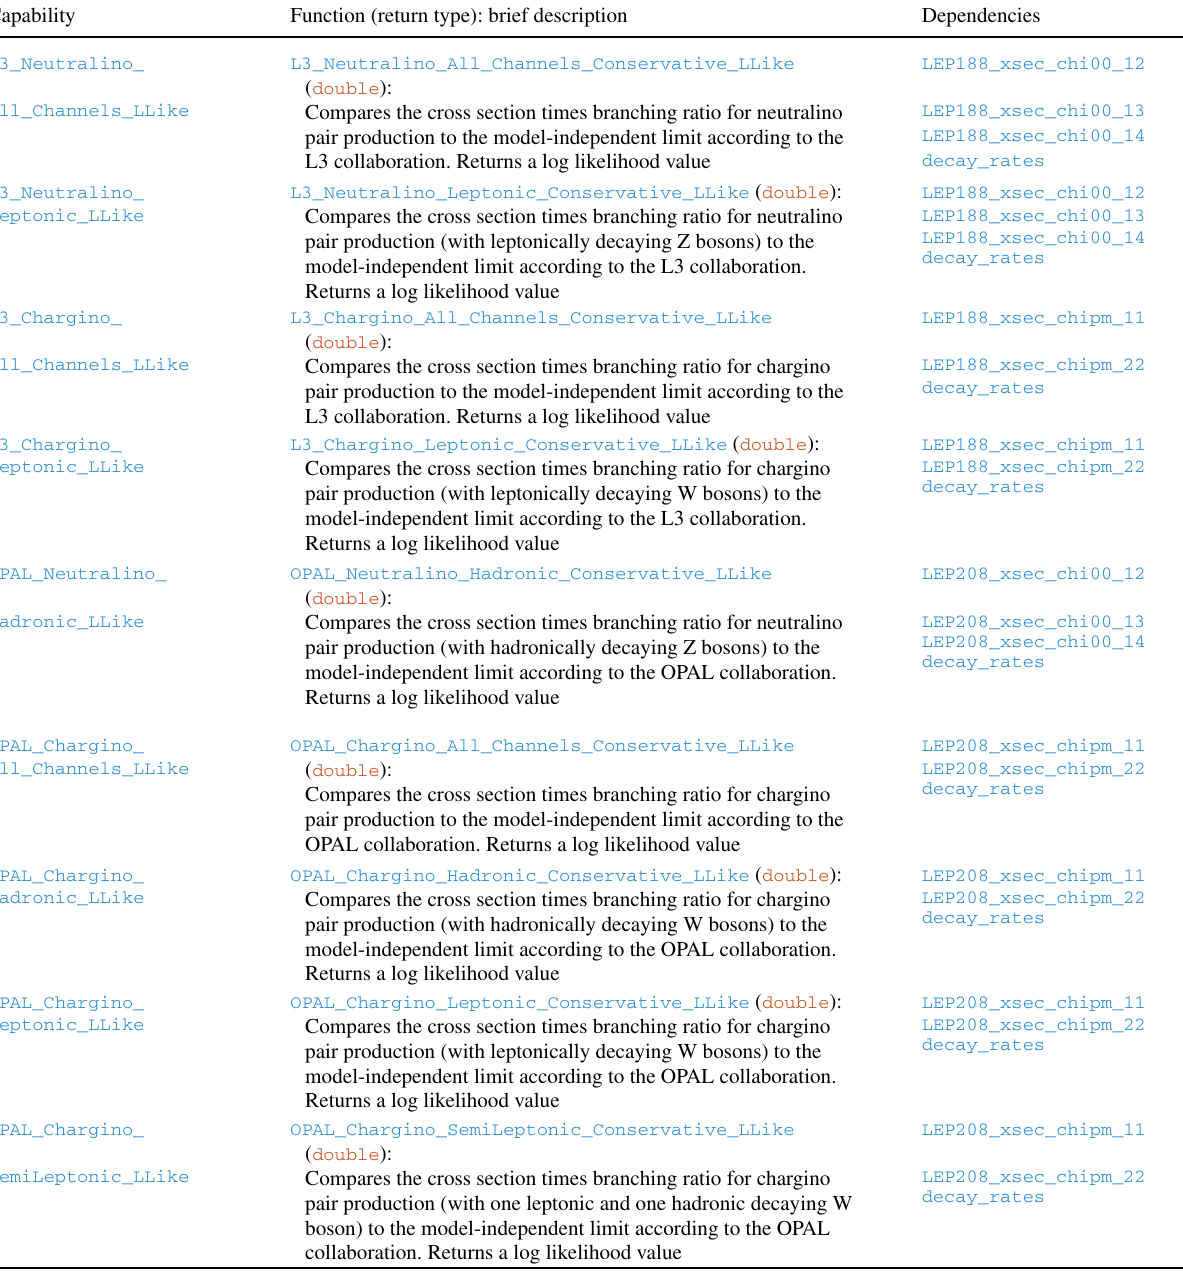
Table 13 The gaugino LEP limit capabilities provided by ColliderBit . In addition to the dependencies shown above, all of these functions also depend on GAMBIT ’s MSSM30atMGUT [1] model parameters and SpecBit ’s MSSM_spectrum [40] capability. Each of the decay_rates can be provided by DecayBit [40]. These functions have no options to